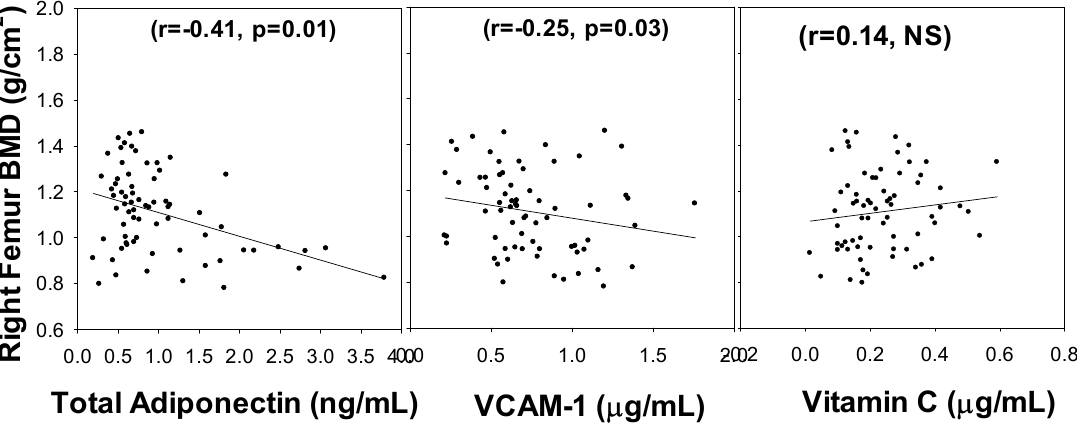
Figure 3. Correlation of Right Femur BMD with blood levels of total adiponectin, VCAM-1, and vitamin C in subjects with diabetes. NS, not-significant. P -values were determined using multiple regression analyses and controlling for BMI and duration of diabetes.